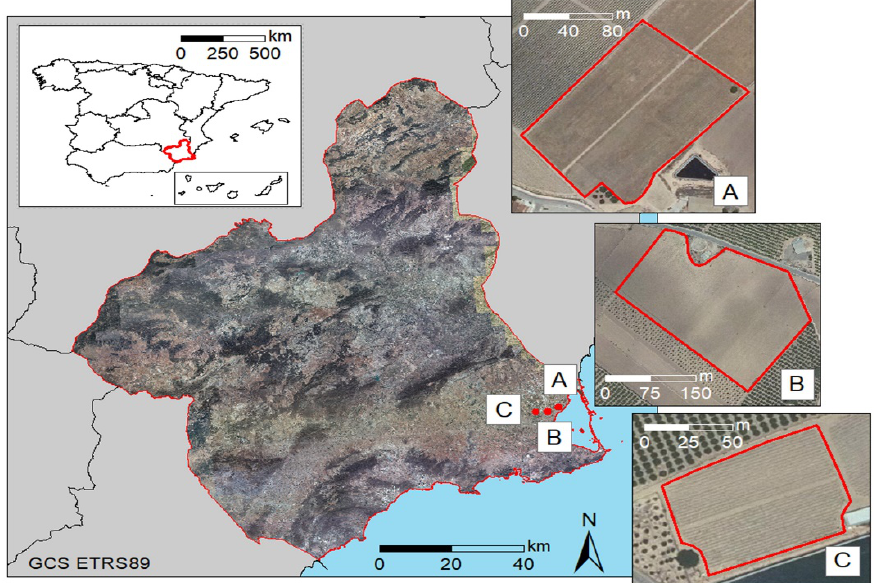
Figure 1. Location of the study sites in Southeast Spain: ( A ) Plot 1, Los Alcáceres; ( B ) Plot 2, Los Alcáceres; ( C ) Plot 3, Torre Pacheco.